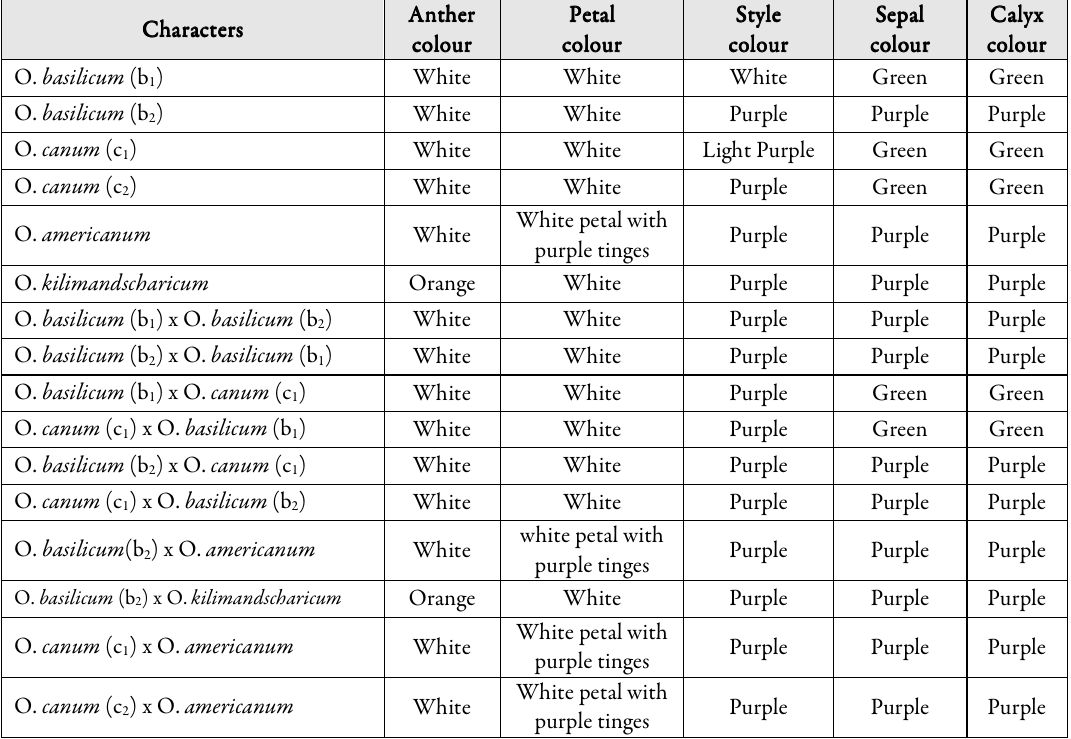
Table 3. Qualitative characteristics of Ocimum spp. and their F 1 hybrids